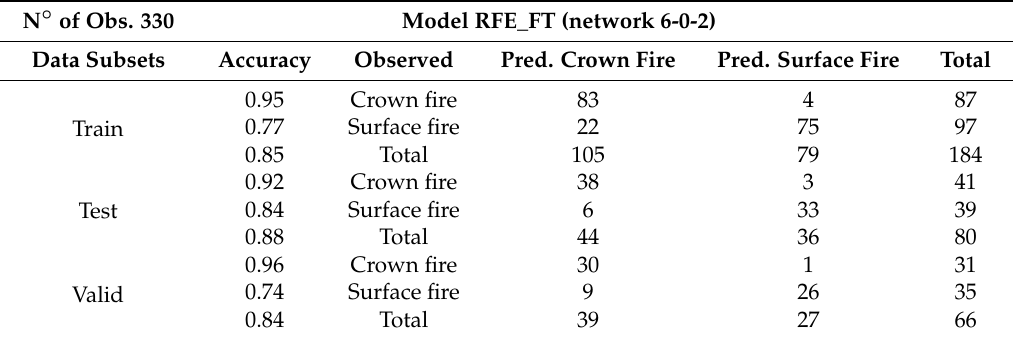
Table 10. Best model architecture and confusion matrix for the classification of Fire Type in Eucalyptus sp. N ◦ of Obs.